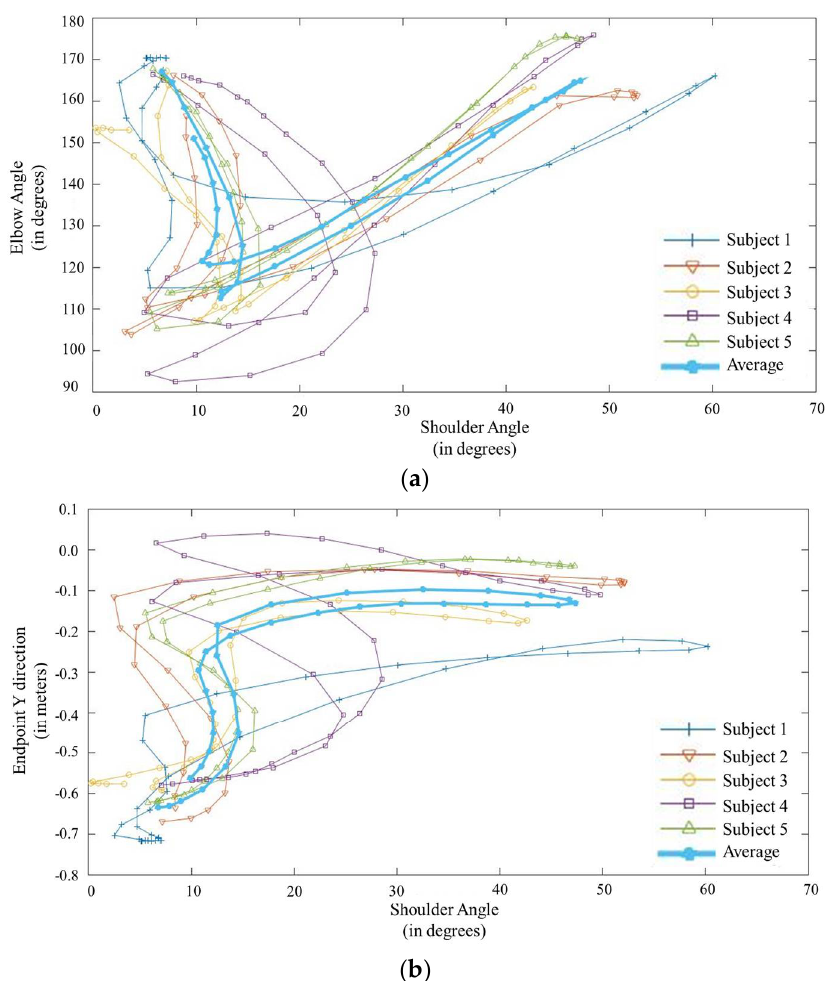
Figure 8. Motion relationships. ( a ) Elbow flexion/extension angle to the shoulder flexion/extension angle for reaching. ( b ) Variation of the endpoint with the shoulder flexion/extension angle.